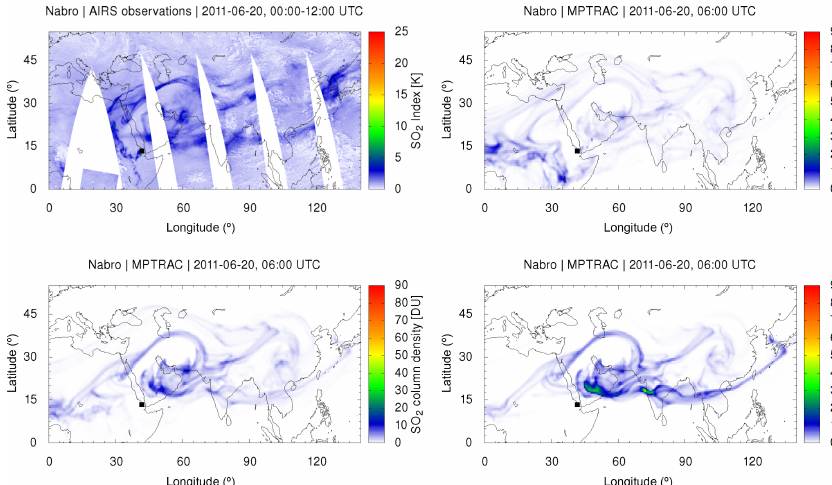
Figure 16. Same as Fig. 11, but for 20 June 2011,